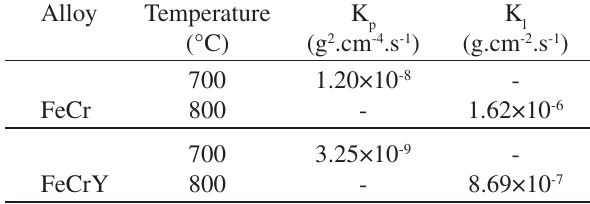
Table I. Parabolic and Linear Sulfidation Constants of the Alloys.